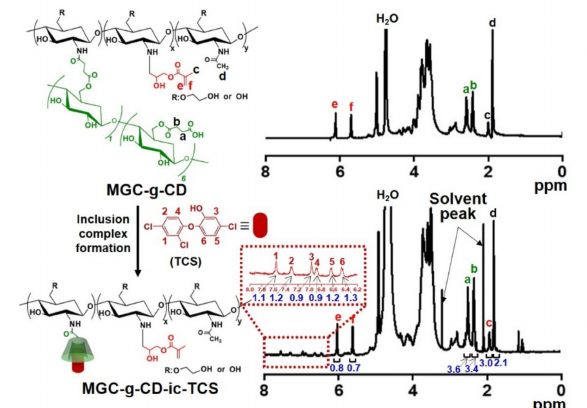
Figure 2. 1 H NMR spectra of MGC-g-CD and MGC-g-CD-ic-TCS analyzed using D 2 O. a and b— CH2CH2- peak of succinyl β -CD; c, e, and f-methyl and vinyl groups of glycidyl methacrylate; d-methyl group of glycol chitosan. The numbers from 1 to 6 in the dotted line indicated triclosan.